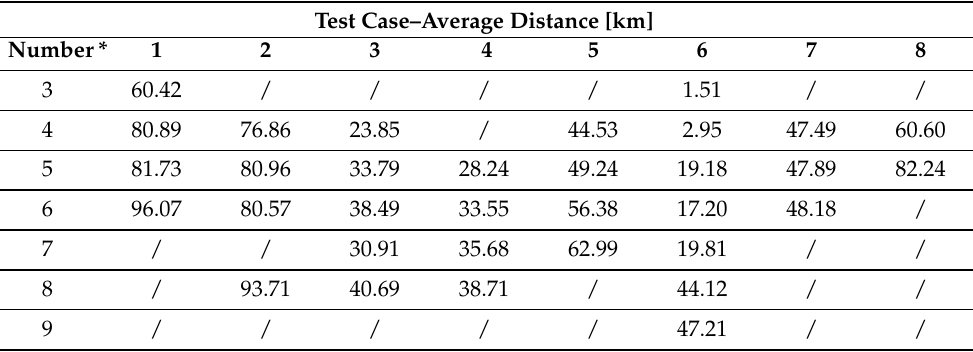
Table 5. The average distances between the IoT sensors and test cases, when different numbers of IoT sensors were considered.